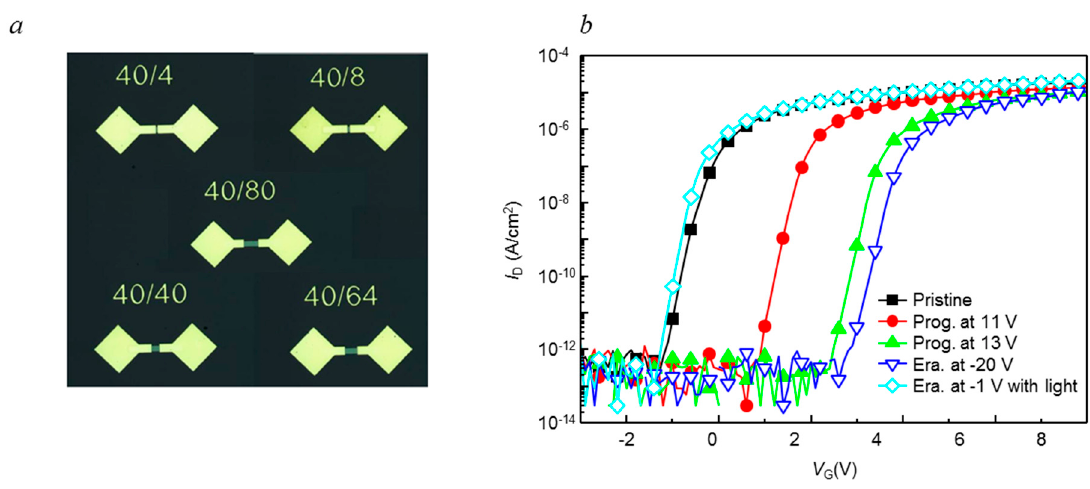
Figure 5. ( a ) Optical microscopy image of the fabricated ITZO NVM and ( b ) Programming and erasing characteristics of the Metal/SiO 2 /SiO X /SiO X N Y /ITZO NVM.